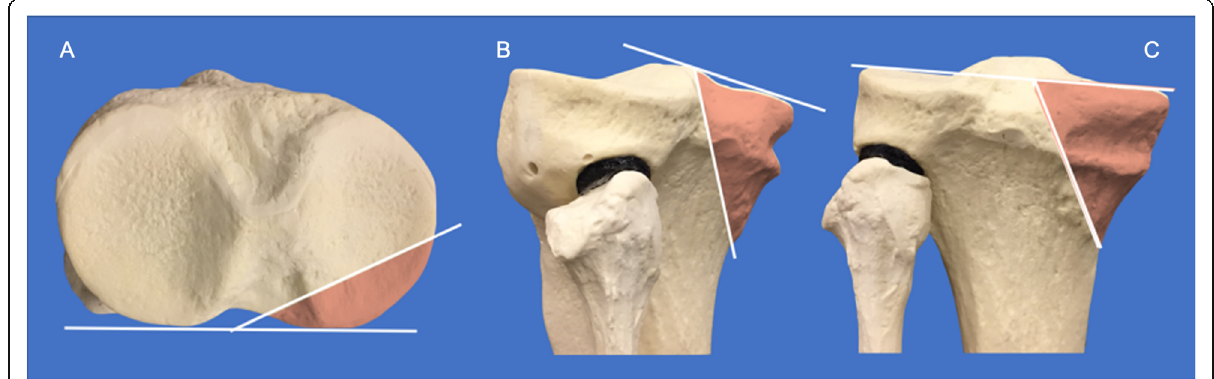
Fig. 1 A posteromedial fracture line was drawn with the articular fragment angle ( α ) of approximately − 25° and the sagittal angle ( β ) equal to 75°. Note the orientation of the fracture on the axial view ( a ), internal oblique view ( b ), and coronal posterior view ( c